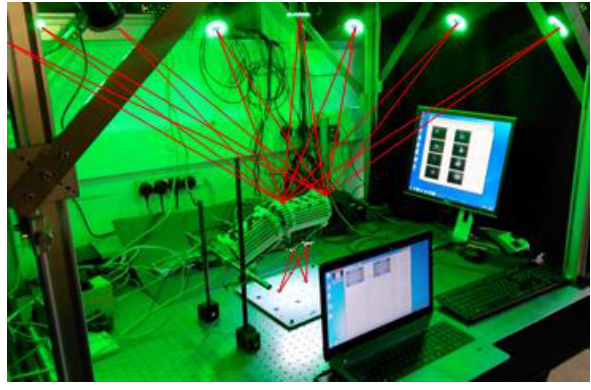
Figure 10. Measurement process, indirect case